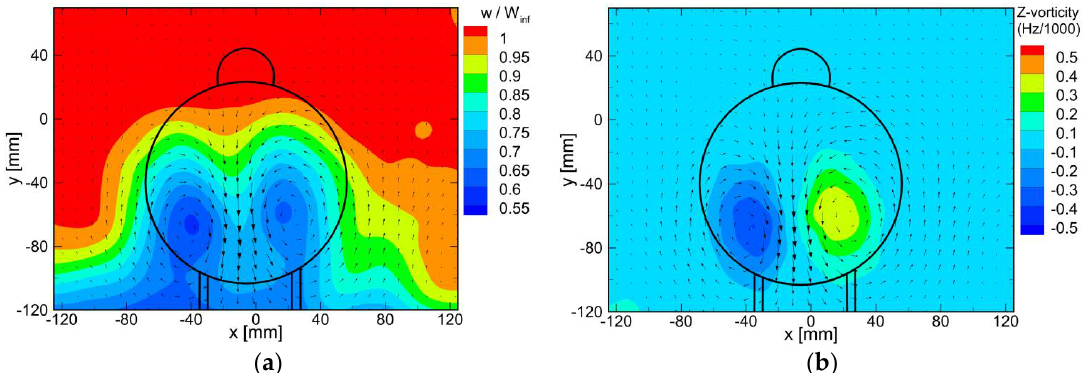
Figure 4. Time-averaged streamwise velocity component ( a ) and streamwise vorticity component ( b ) at z/D = 2 for no nose rotation.